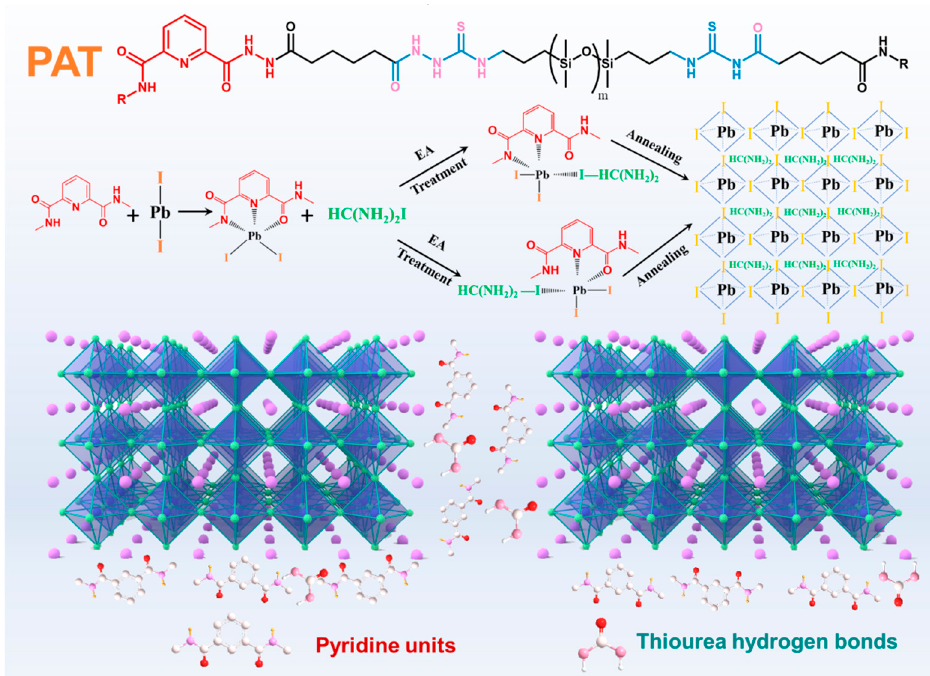
Figure 1. Proposed mechanisms of passivation and self-healing characteristics, and the physical structure of devices.